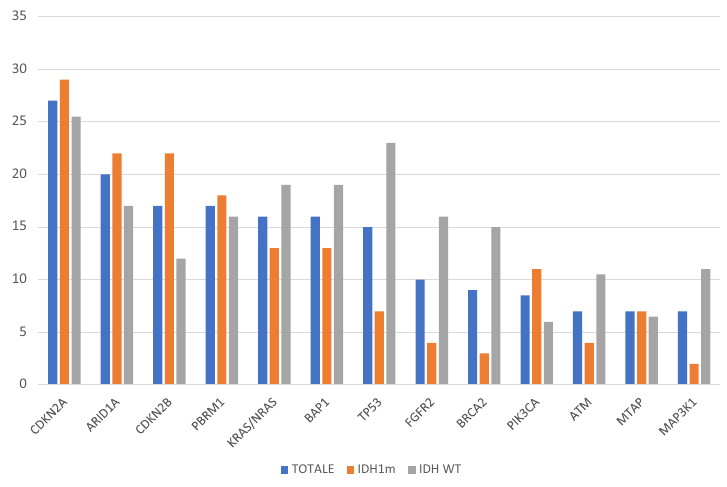
Figure 1. Most common altered genes in the whole sample, in IDH1m patients and in IDH1wt